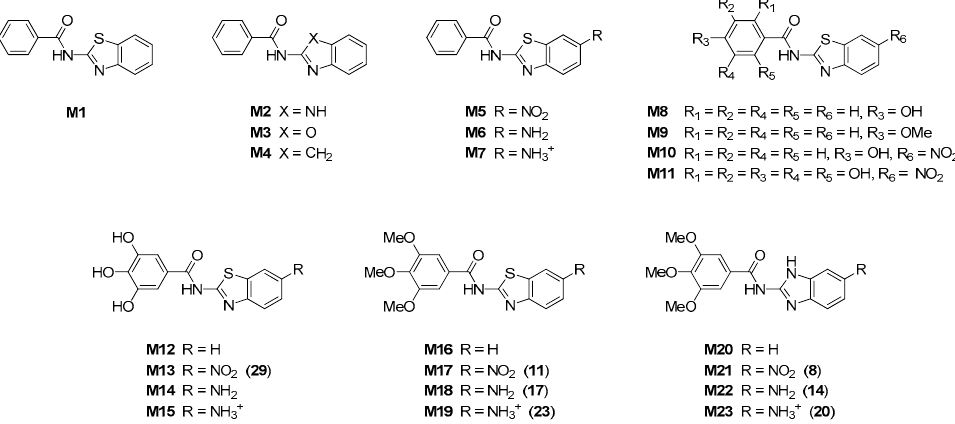
Figure 2. Schematic representation of molecules examined computationally, with numbers in round brackets relating to experimentally studied systems.